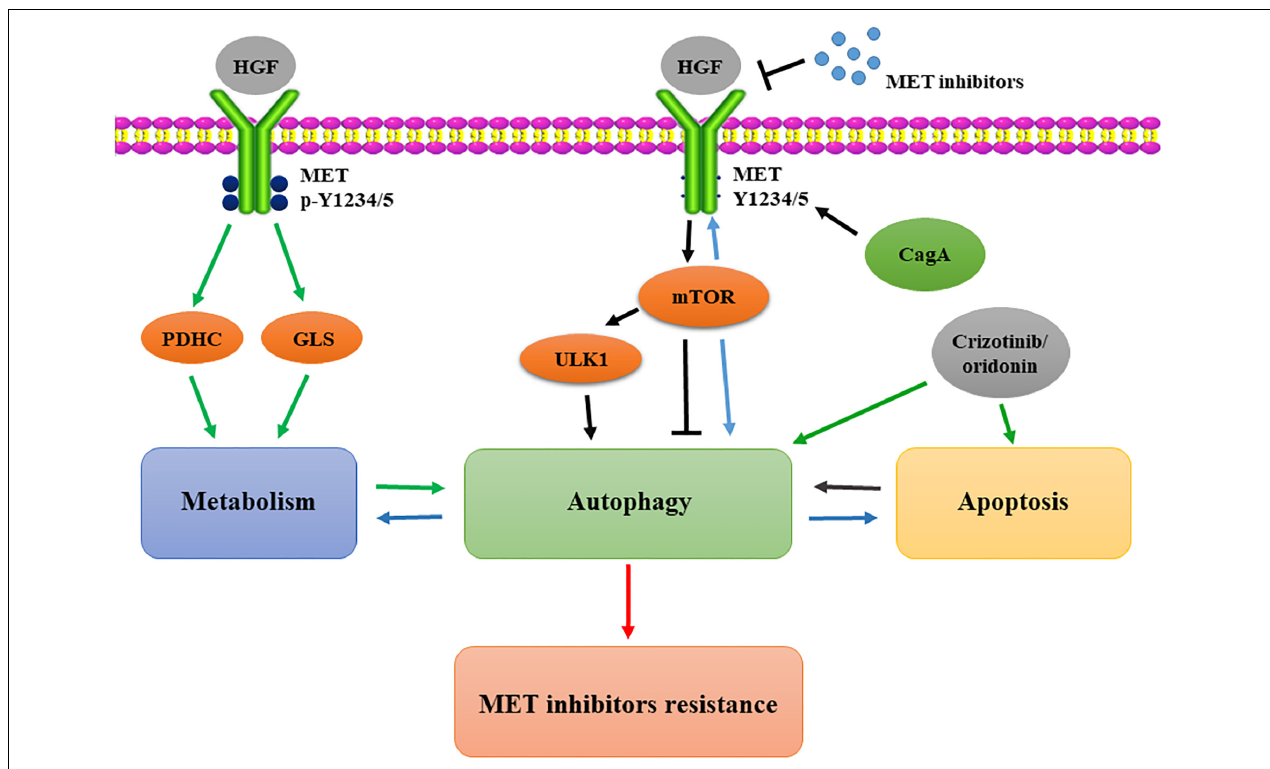
FIGURE 3 | Autophagic compensation in resistance to MET-targeted therapy. CagA protein negatively regulates autophagy via the MET-mTOR signaling pathway; MET inhibition induces mTOR activation and ULK1 dephosphorylation to increase autophagy; Y1234/1235 dephosphorylation of MET mediates the metabolic transformation to autophagy; crizotinib and oridonin strengthen the positive feedback loop between autophagy and apoptosis in the resistance. mTOR, mammalian target of rapamycin; PDHC, pyruvate dehydrogenase complex; GLS, glutaminase; ULK1, UNC-51–like